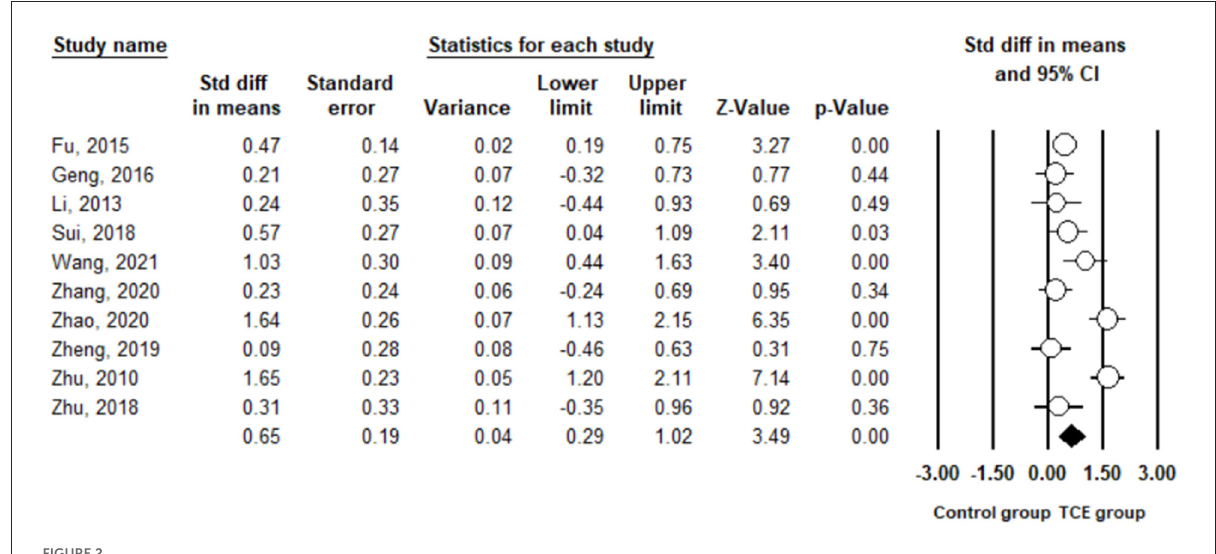
FIGURE2 The effect of Traditional Chinese exercises on the